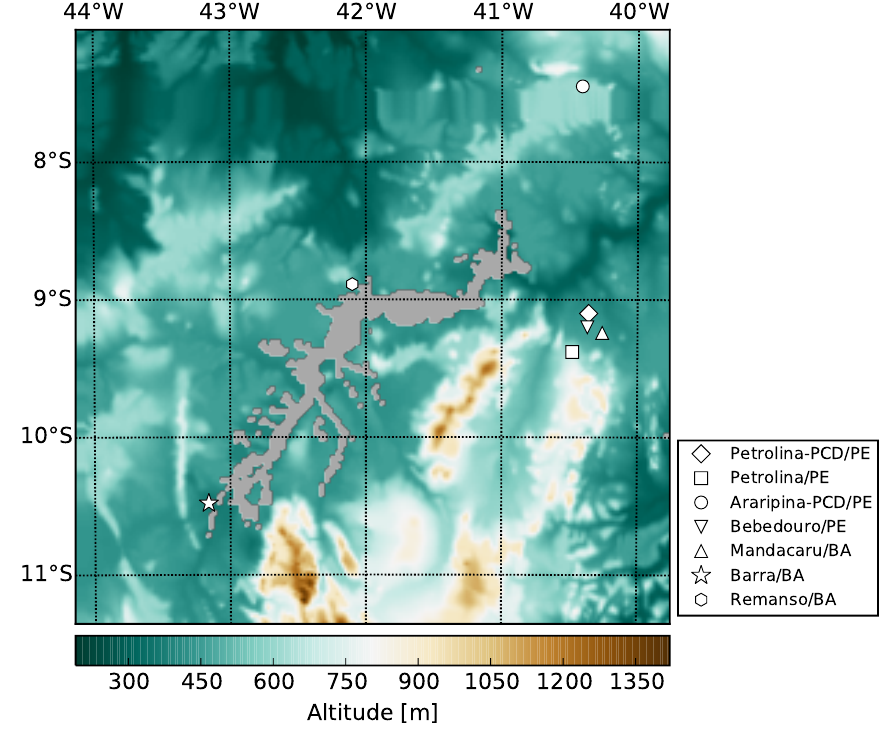
Figure 2. Geographical setting and meteorological stations used for model evaluation. The gray area represents the geographical extent of Lake